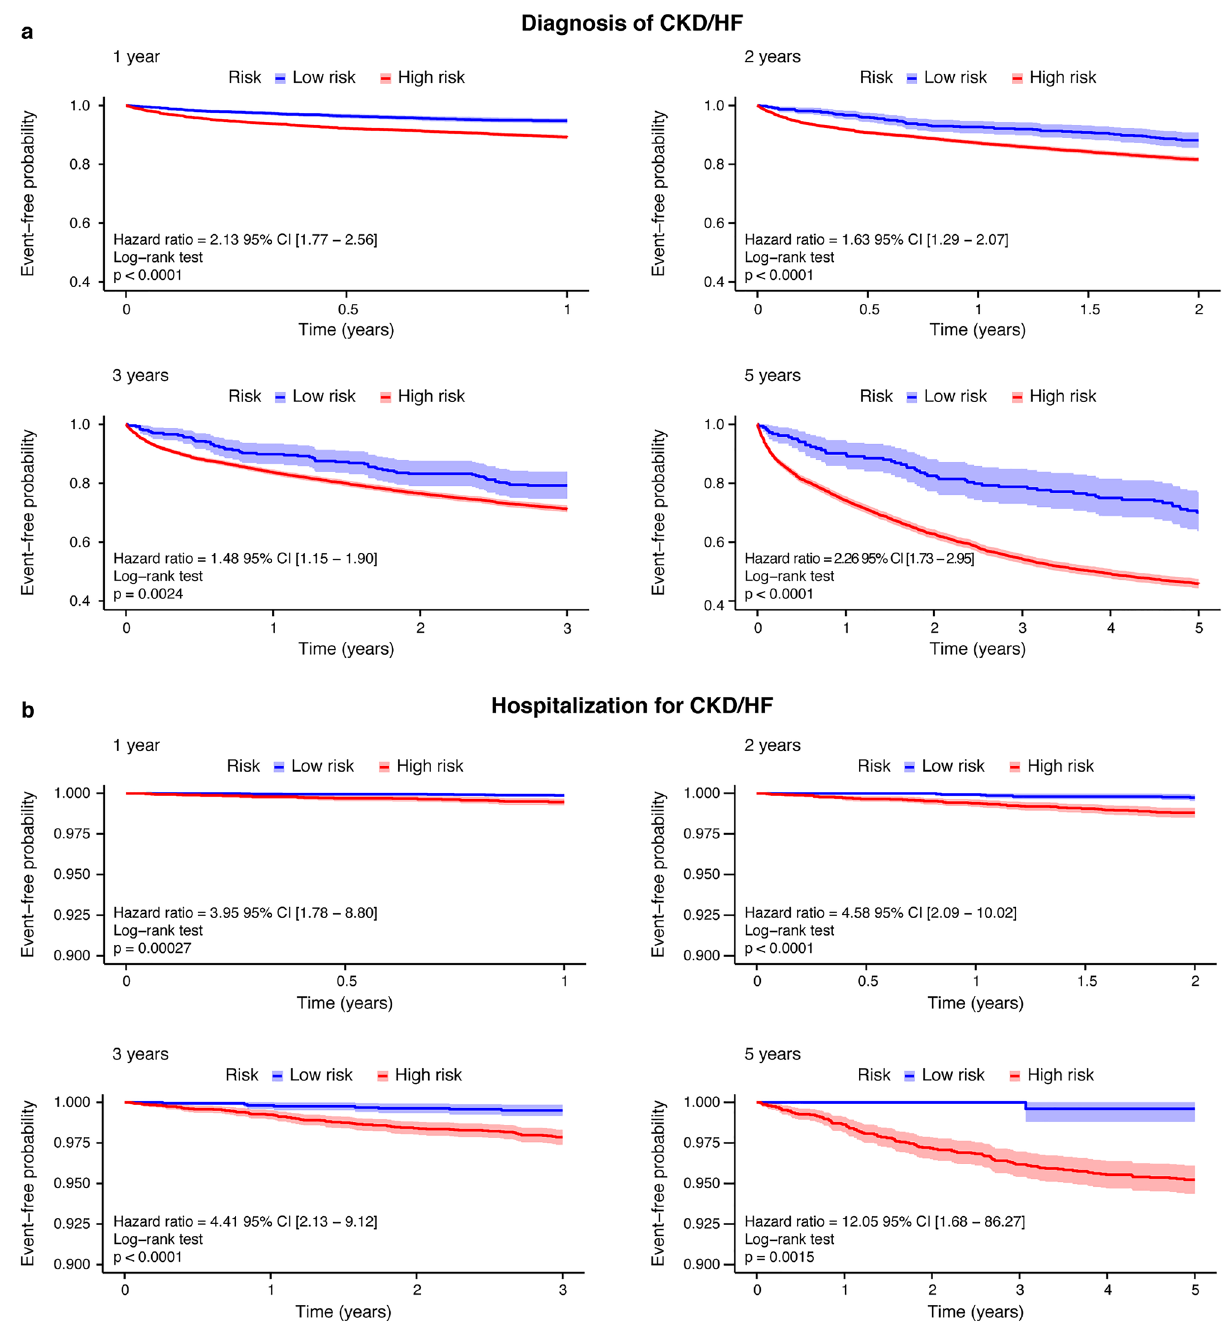
Figure 6. Kaplan–Meier plots of the high-risk and low-risk groups based on risk predictions for primary outcomes in the external validation set. ( a ) Diagnosis of CKD/HF and ( b ) hospitalizations for CKD/HF. CKD chronic kidney disease, HF heart